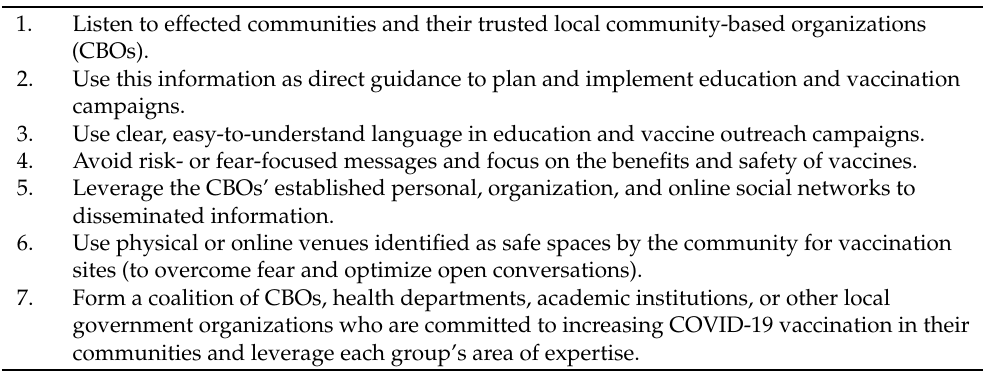
Table 1. Strategies to promote COVID-19 vaccine uptake in African American and Latino